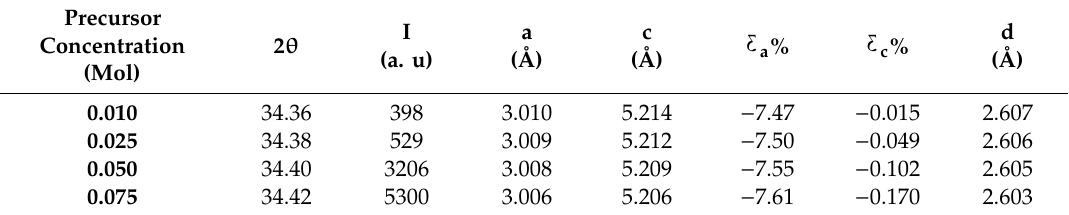
Table 2. Lattice parameters and structure properties of di ff raction peak (002) at di ff erent precursor concentrations of ZnO nanorods synthesized by modified CBD